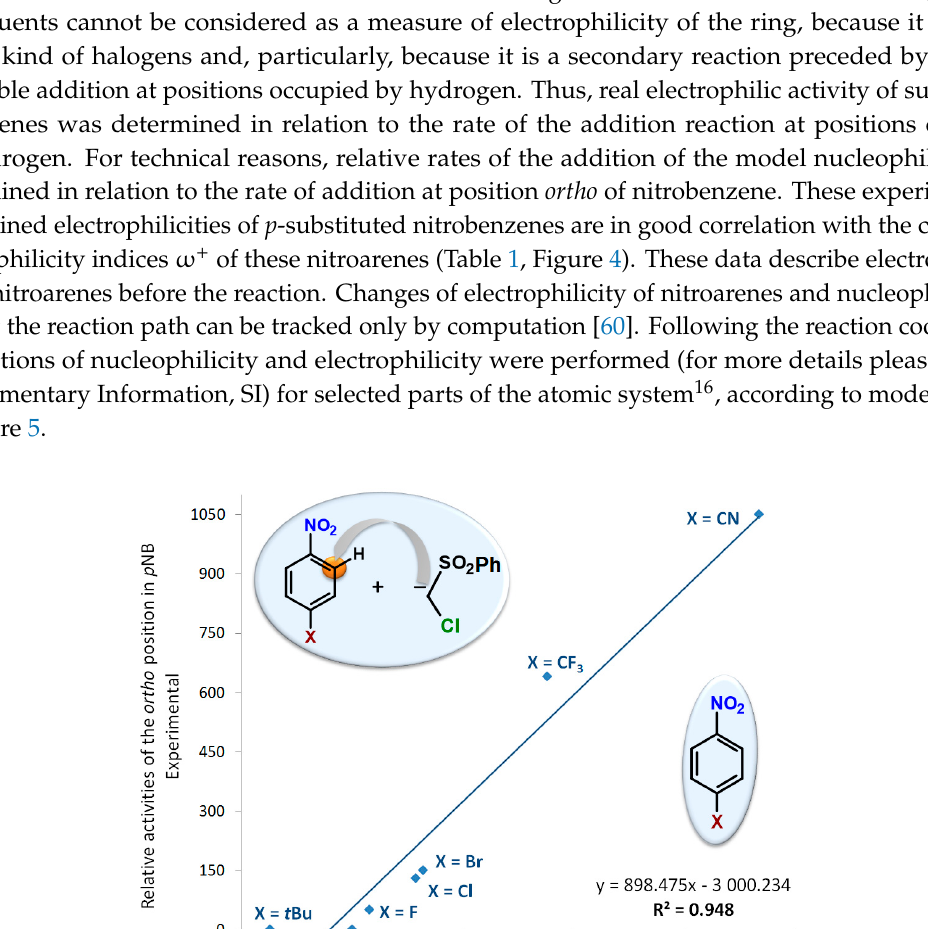
Figure 4. The correlation between the calculated electrophilicity potential ω + (eV) of p NB and the experimental relative activities of the ortho position in the case of the S N Ar-H reaction.